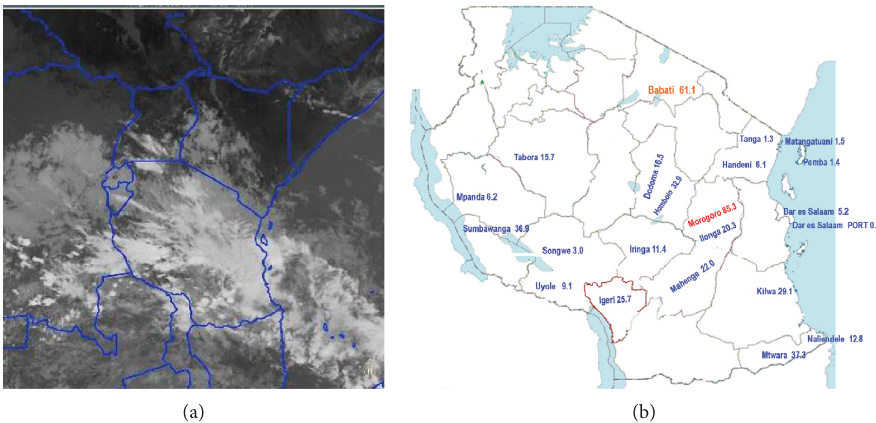
Figure 9: (a) Infrared satellite (IR) image for the day (1015 UTC, 11/01/2018) (retrieved from https://en.sat24.com/en/af/infraPolair) and (b) the twenty-four-hour (January 11, 2018) rainfall (mm) distribution (preliminaries prior to the forecast of the day) in Tanzania as extracted from the official YouTube (https://www.youtube.com/watch?v � ohd4t4BMsnk) channel of the Tanzania Meteorological Agency.